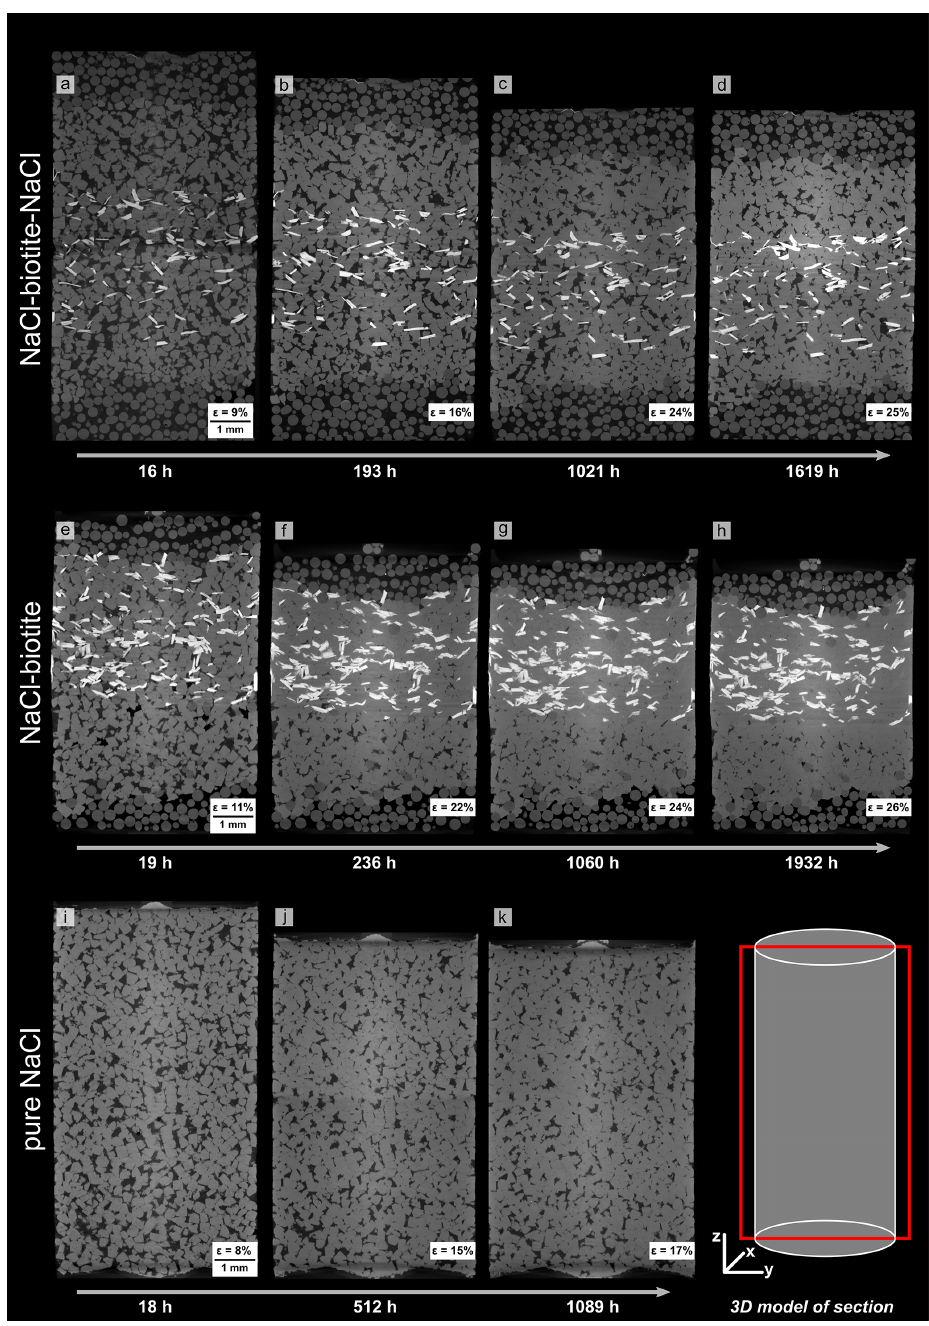
Figure 5. Vertical slices through absorption µ CT scans at different stages of compaction. The 3-D model in the lower right corner shows the location of the section within the bulk samples. Different shades of grey refer to different phases present in the samples (in black: brine- filled pore space, dark grey: glass beads, grey: NaCl grains and light grey: biotite). The top and middle rows show the NaCl–biotite samples SBS (a–d) and SB (e–h) , respectively, the bottom row displays the pure NaCl sample (i–k) . Panels (b) , (f) and (j) show first signs of porosity reduction and indentation of NaCl grains which we interpret as indicators for active dissolution–precipitation creep and which is continuing throughout the experiment. Note that the final scan of the SB sample (h) shows no remaining porosity in the biotite-bearing layers, whereas it is still clearly visible in the SBS (d) and the pure NaCl sample (k)